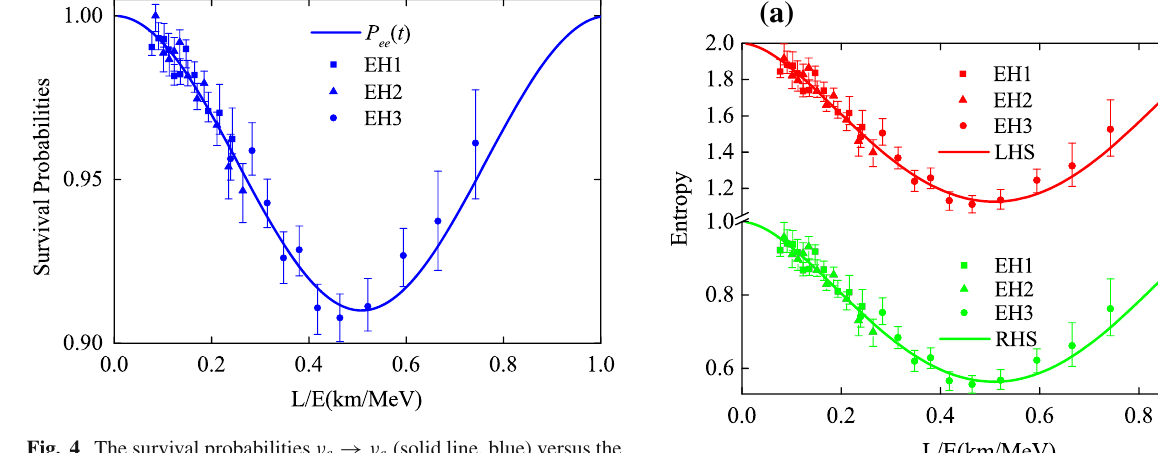
Fig. 4 The survival probabilities ν e → ν e (solid line, blue) versus the distance traveled per energy L / E with the initial electron flavor state. ThesolidlineistheoreticalvalueandthedataofDayaBayCollaboration in three different underground experimental halls (EH1: square; EH2: upper triangle; EH3: circle) are taken from Ref. [19]